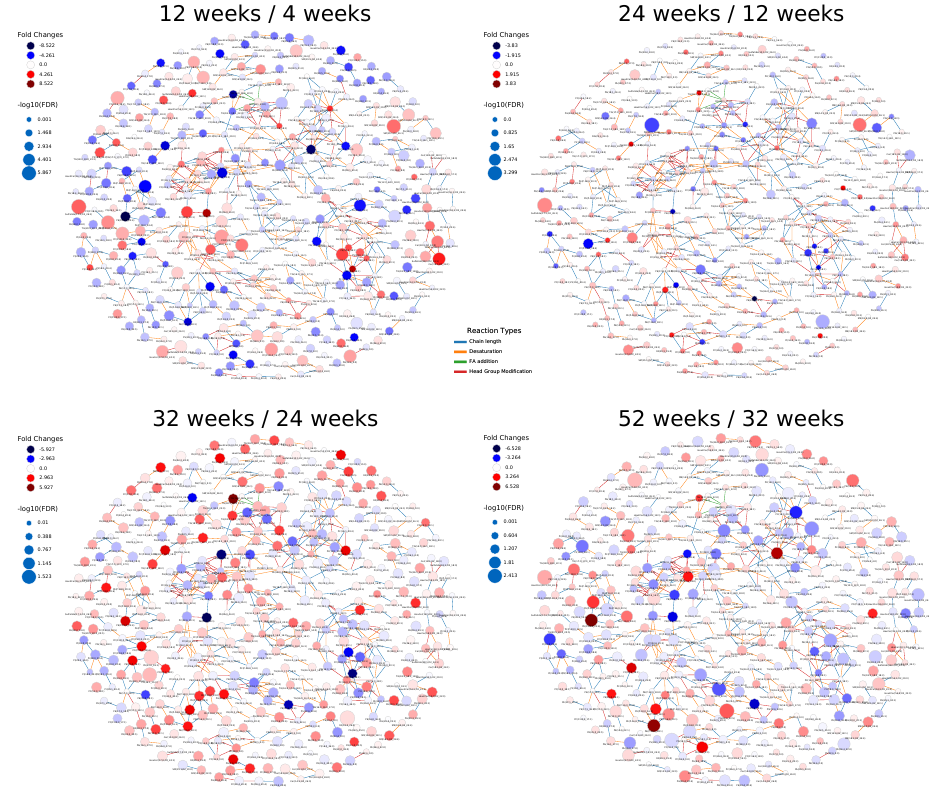
Figure A5. Fold changes of lipids visualized on lipid networks of the lipidomics data from Tu et al. [19]. Node size scaled by negative log10 of the p -values for comparison between healthy and cancer tissue. Lipids are colored by log fold change between mouse brain age groups. Blue indicates negative fold changes and red positive fold changes (e.g., higher levels in 12 weeks compared to 4 weeks are red). Edges are colored by reaction type. Chain length modification (blue), desaturation (orange), fatty acid addition (green) and head group modification